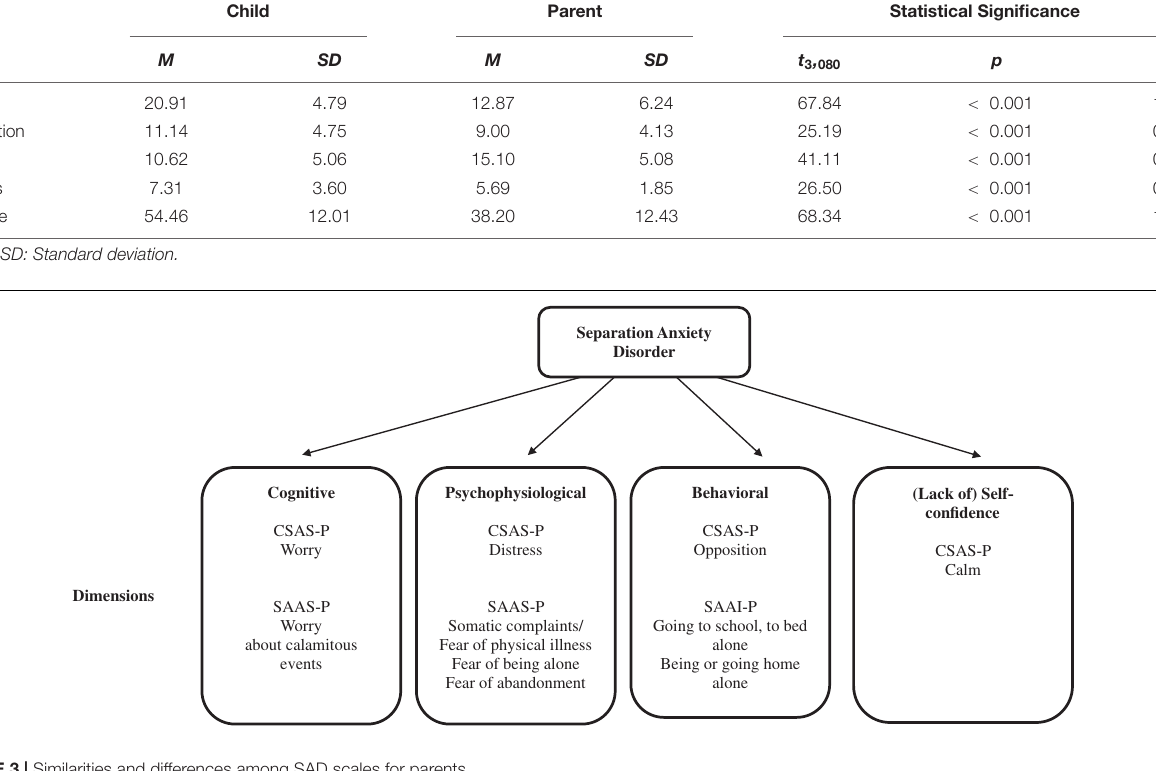
TABLE 8 | Mean and standard deviation of child on CSAS and parent on CSAS-P. Child